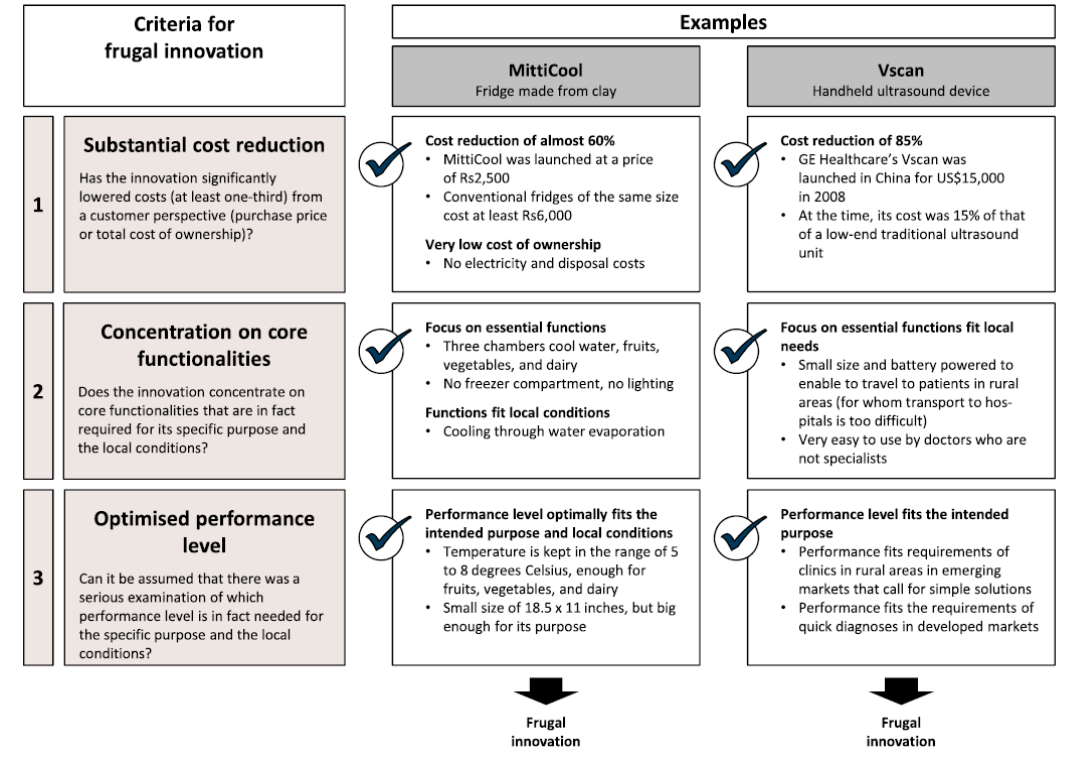
Figure 1. Examples of frugal innovation. Image adapted from [16].